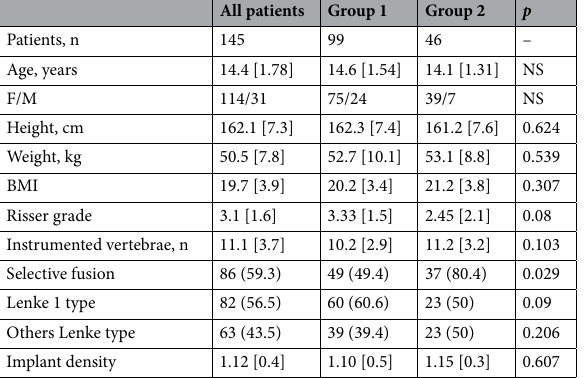
Table 1. Demographic and surgical data; mean [standard deviation] or (% of patients); analysis performed using IBM SPSS Statistics 21. BMI, body mass index; NS, not significant.